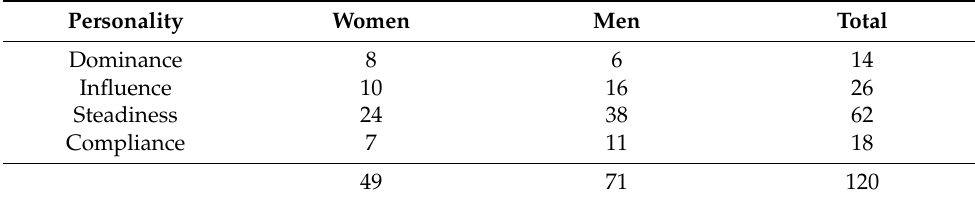
Table 3. Results of the personality